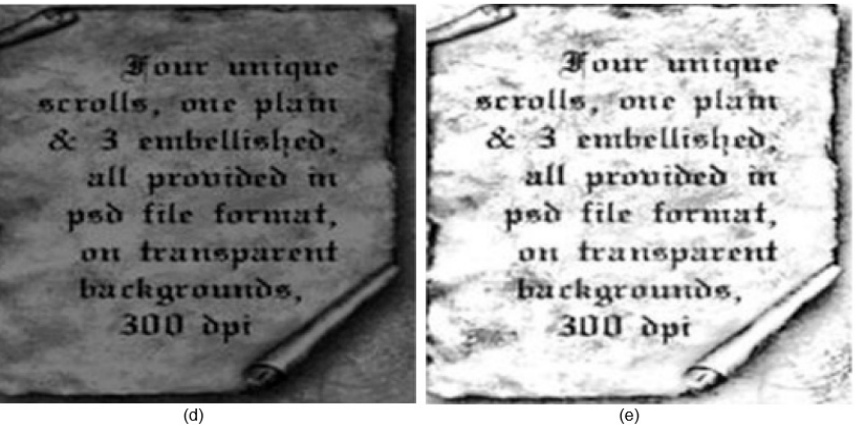
Figure 7. Qualitative results S-MS [27]: ( a ) input image, ( b ) S. Kang [2], ( c ) S. K. Jemni [3], ( d ) proposed LWT and SWT bi-cubic interpolation result, ( e ) proposed final image.